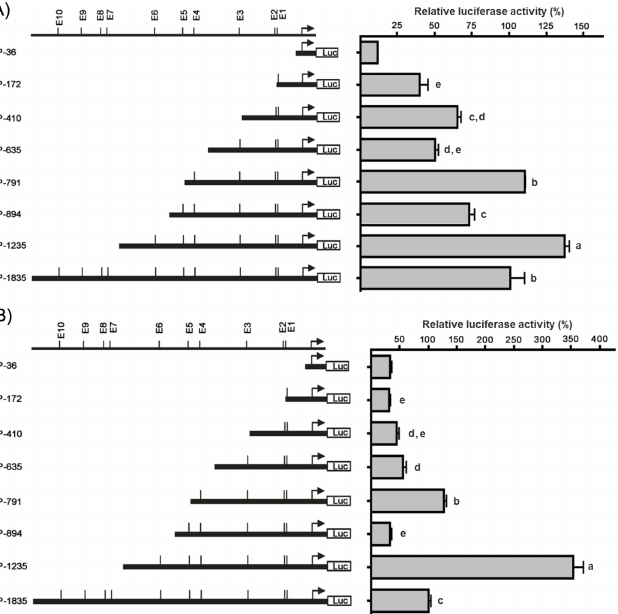
Fig 1. Deletion analysis of grouper myostatin 5’-flanking regulatory regions in vitro and in vivo . The seven promoter constructs were cloned into the luciferase reporter vector pGL3-Basic (left) and transfected into GF-1 cells (A) and grouper larvae muscle (B). The locationsof the E-boxes of the groupermyostatin promoterare presented on the top left. The relative luciferase activity was normalized againstthe activity of the pGL3-Basic vector, and the results are shown in the right panel. Bars indicateaverages ± standard deviations for three replicates and asterisks show significantdifferences ( *** p < 0.001).